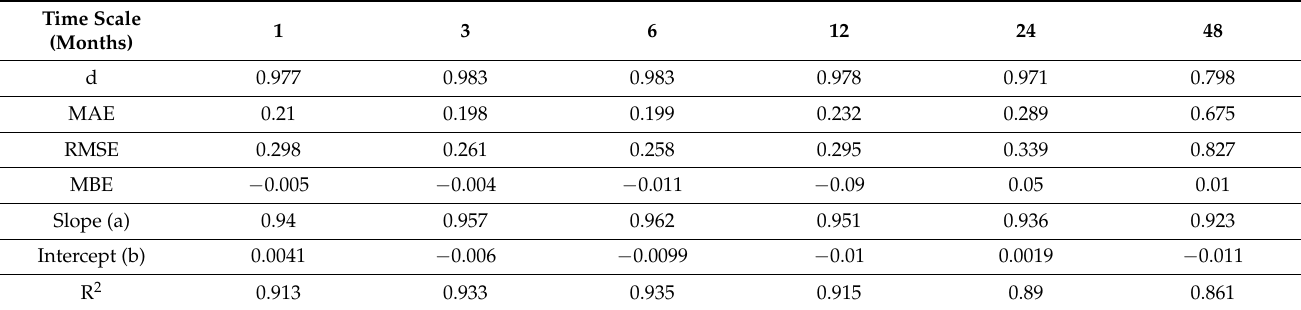
Table 4. Statistic parameters of SPI/SPEI